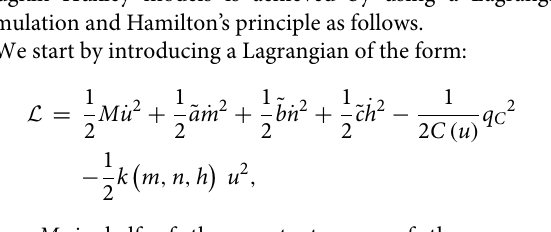
enough to study half of the neuron whose properties are encapsulated into a spring-dashpot-mass mechanical system with the spring and dashpot connected in parallel (Kelvin–Voigt model), and the membrane is represented as an electric circuit governed by the classic Hodgkin–Huxley